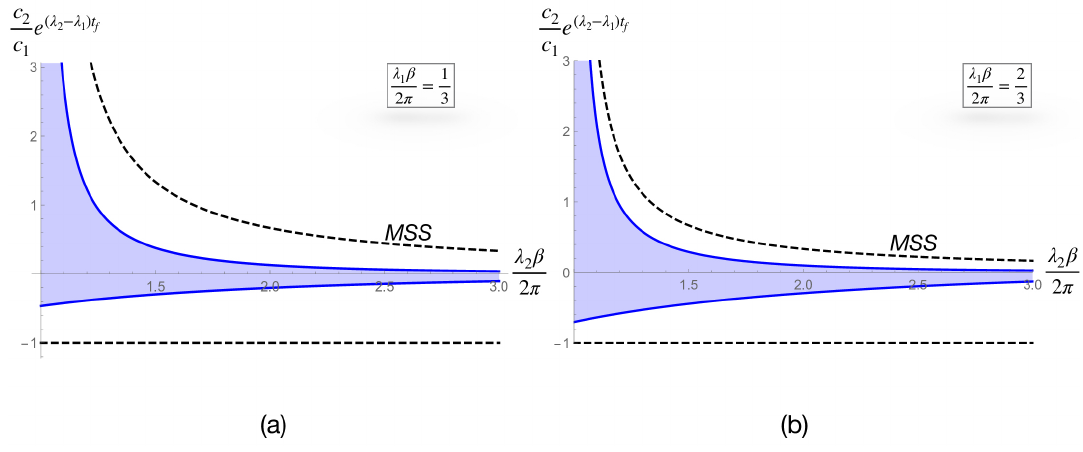
and 2 π . The chaos bounds Figure 4 . Bounds on subleading corrections for λ 1 < 2 π < λ 2 < 6 π β β β necessarily require that c 0 and c is parametrically suppressed. Furthermore, the chaos bounds 1 > 2 of section 3.2 impose two-sided bounds on c as shown here (blue lines) for (a) λ 1 β = 1 and (b) 2 /c 1 2 π 3 λ 1 β = 2 . In particular, the unshaded regions are ruled out by these bounds. Black dashed lines 2 π 3 represent constraints from the MSS bound (4.9) which are strictly